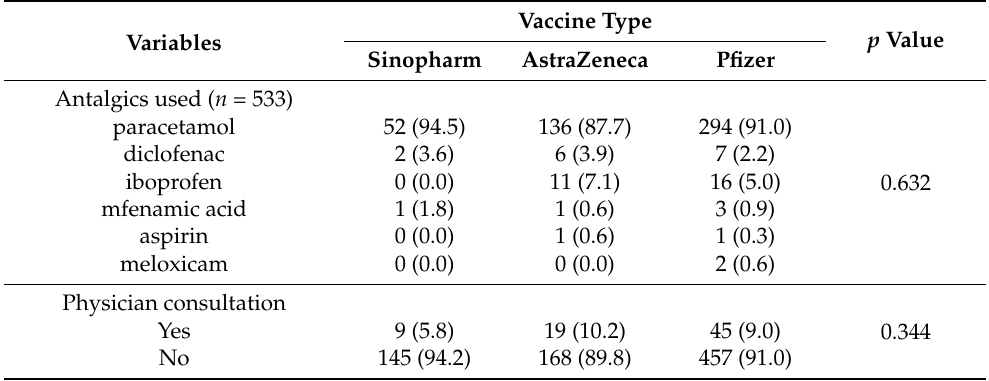
Table 3. Analgesics used and physician consultation of the study